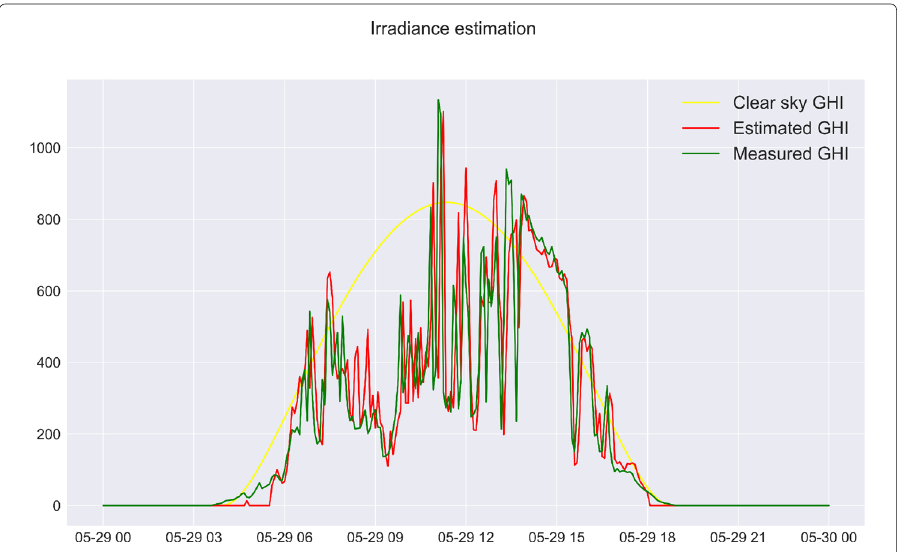
Fig. 5 Measured and estimated GHI on 29.05.2020, MAPE =